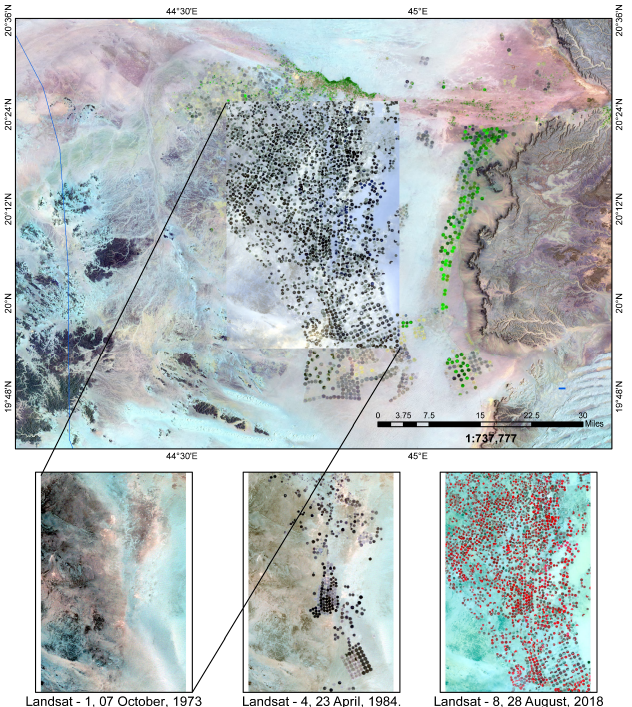
Figure 2. Time-series Landsat satellite images show the temporal change in agricultural activities in the Wadi Al-Dawasir area in the period from 1973 to 2018.